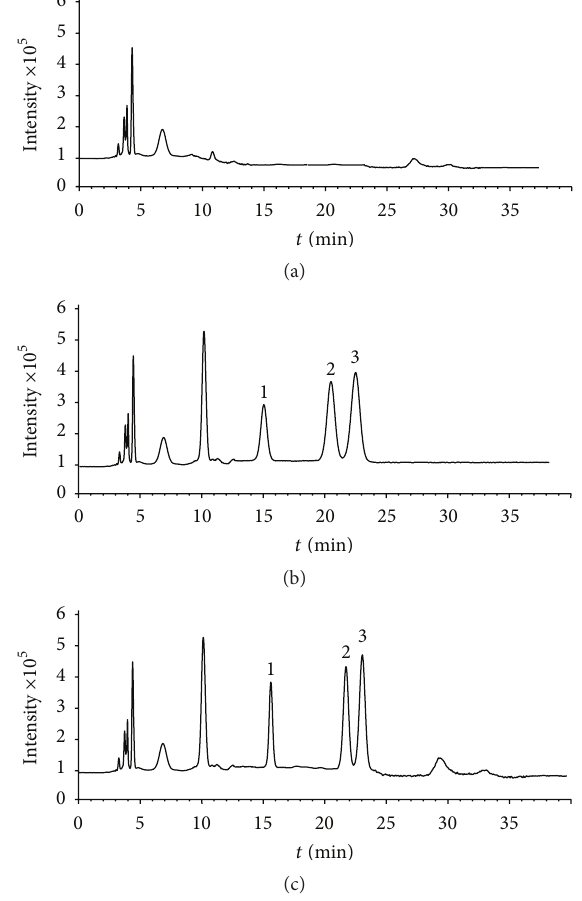
Figure 1: HPLC-MS ion chromatograms of plasma samples. (a) blank plasma samples; (b) plasma standard solutions of 5.0 𝜇 g ⋅ mL −1 NGR1, 3.0 𝜇 g ⋅ mL −1 GRg1, and 8.0 𝜇 g ⋅ mL −1 GRe; (c) plasma